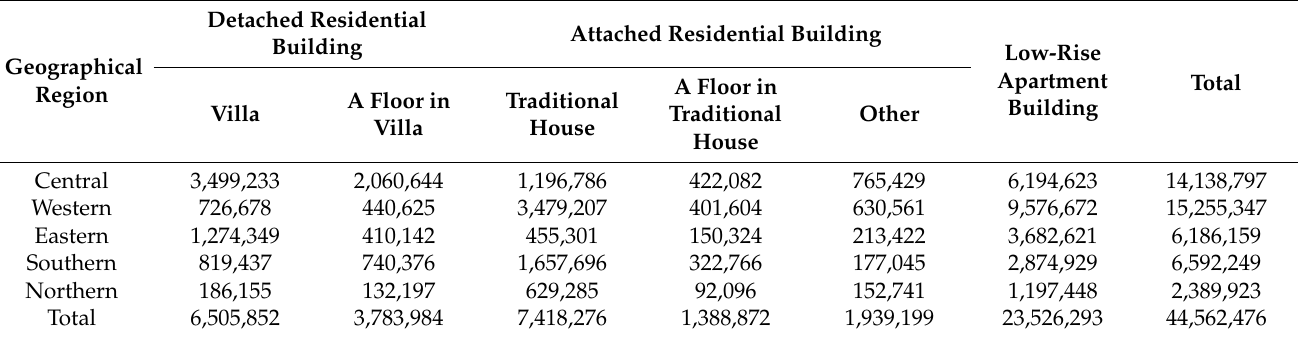
Table A2. Estimation of population prediction based on the geographical region